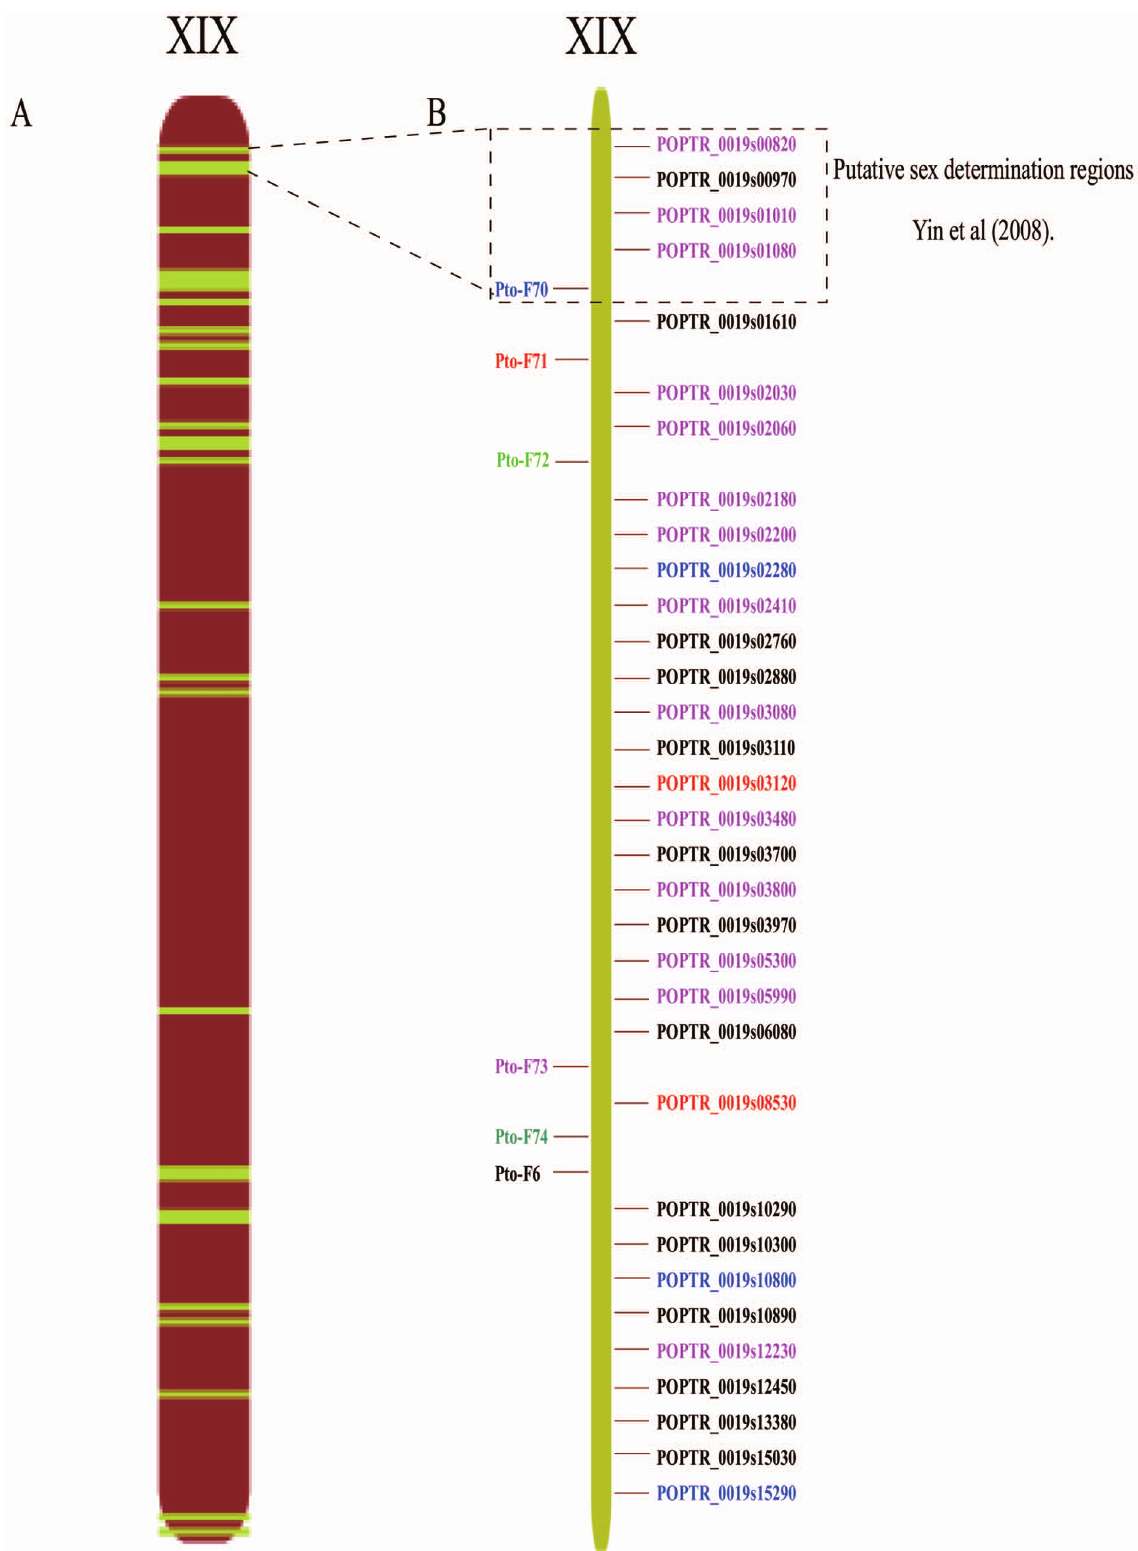
Figure 4. Distribution of novel miRNAs on chromosome XIX. A. 6 novel miRNAs and their targets located on chromosome XIX. B. Schematic diagram of the order of 6 novel miRNAs and their targets on chromosome XIX. Each miRNA and corresponding targets are marked the same color. Putative sex determination region in a 2.45-Mb region at the peritelomeric end of chromosome XIX, based on Yin et al (2008).